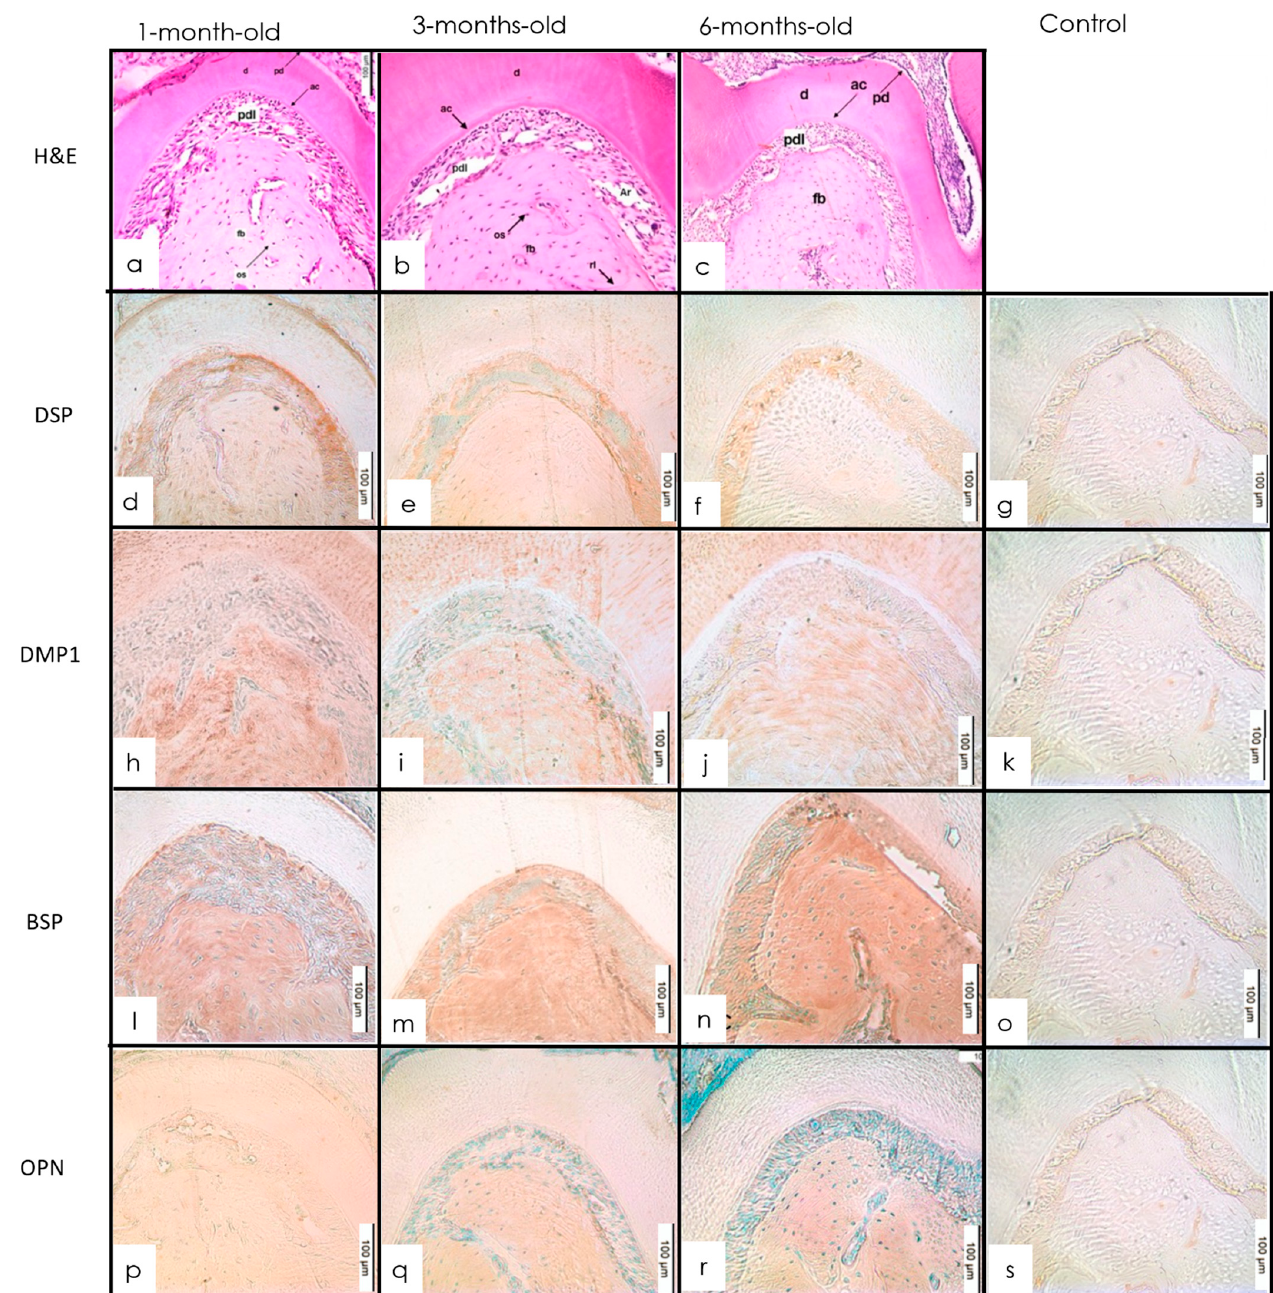
Figure 4. ( a – c ) H&E molar showing furcation alveolar bone 1-, 3-, and 6-month-old mice (H&E 20 × ). The furcation bone is well-developed in all age groups. d—dentin; pd—predentin; o—odontoblastic layer; p—pulp; fb—furcal bone; pdl—periodontal ligament; tf—transeptal fibers; Iab—interproximal alveolar bone. ( d – g ) Expression of staining intensity of DSP at 1, 3, and 6 months in furcation bone with anti-DSP (IHC 20 × ). Intensity decreased from 1 to 3 months followed by a slight decrease between 3 and 6 months. ( h – k ) IHC staining of furcation alveolar bone in 1-, 3-, and 6-month-old mice with anti-DMP1 (IHC 20 × ). Intensity decreased from 1 to 3 months and decreased further between 3 and 6 months. ( l – o ) IHC staining of furcation alveolar bone in 1-, 3-, and 6-month-old mice with anti-BSP (IHC 20 × ). Intensity decreased slightly from 1 to 3 months followed by an increase between 3 and 6 months. ( p – s ) IHC staining of furcation alveolar bone in 1-, 3-, and 6-month-old mice with anti-OPN (IHC 20 × ). Intensity decreased from 1 to 3 months followed by an increase